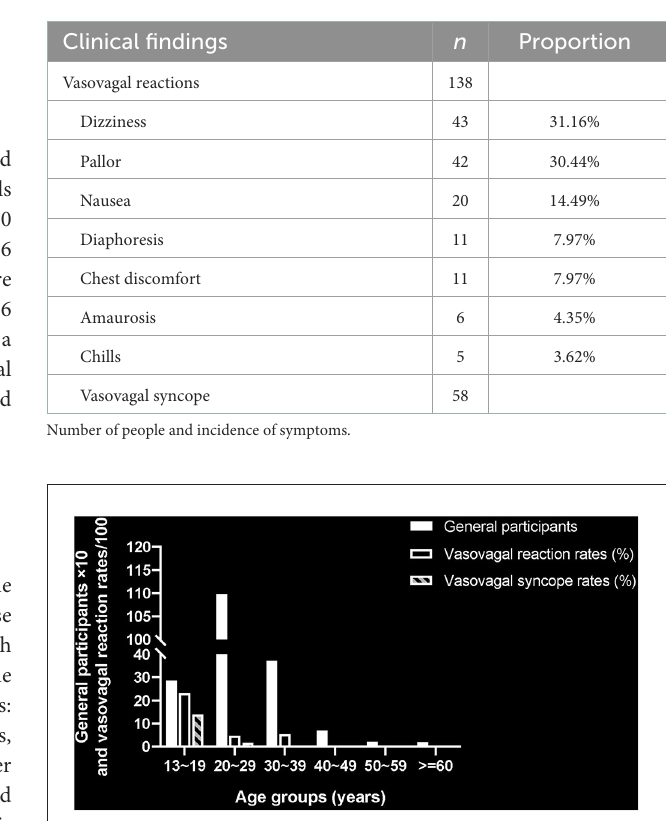
FIGURE1 Comparison of participant’s numbers and the vasovagal reaction rates.